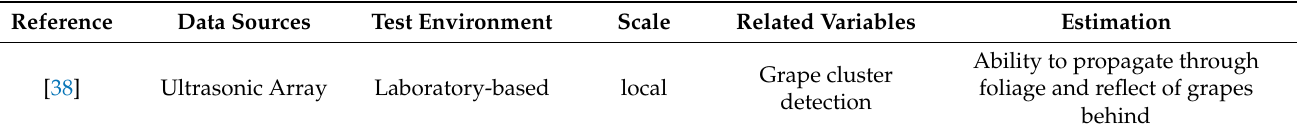
Table 10. Summary of records included in the systematic review (I—data-driven models based on ultrasonic signal processing.).